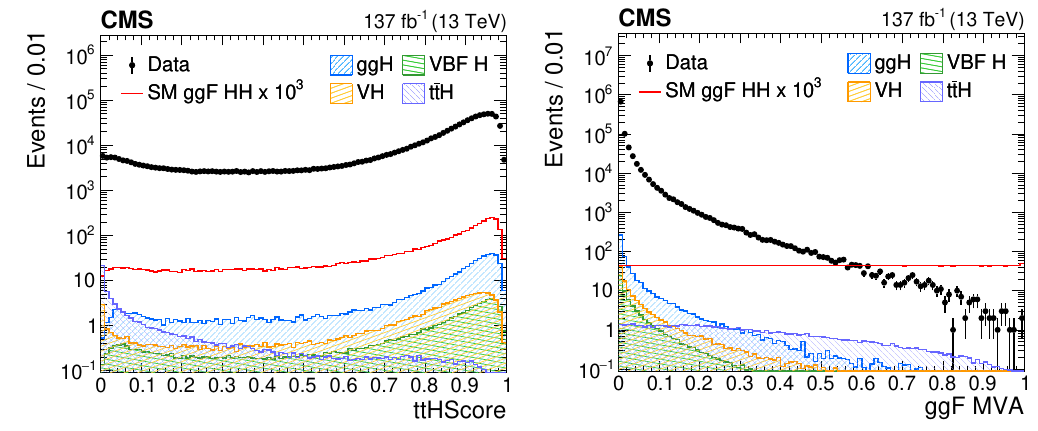
Figure 5 . The distribution of the ttHScore (left) and MVA output (right) in data and simulated events. Data, dominated by γγ + jets and γ + jets background, are compared to the SM ggF HH signal samples and single H samples ( ttH , ggH , VBF H , VH ) after imposing the selection criteria described in section 5. The error bars on the data points indicate statistical uncertainties. The HH signal has been scaled by a factor of 10 3 for display